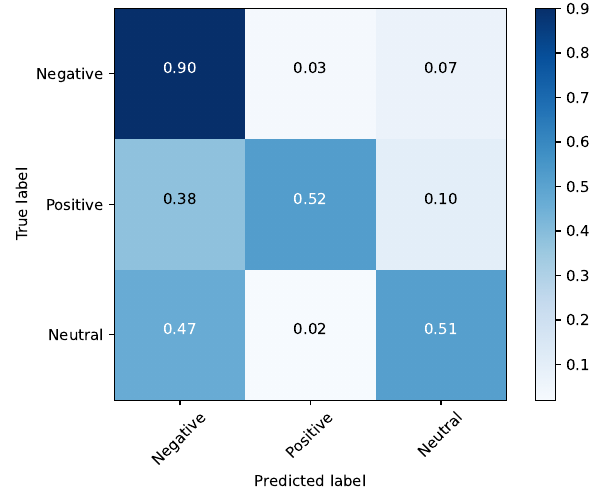
Figure 12. Testing set (SFEW) and clustered